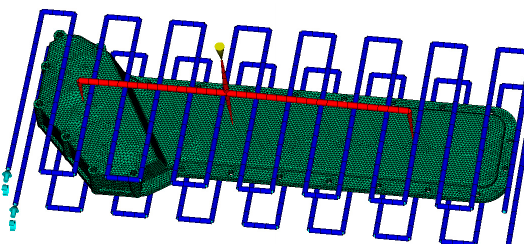
Figure 8. The FE model of the injection molding system of the oil cooler cover.